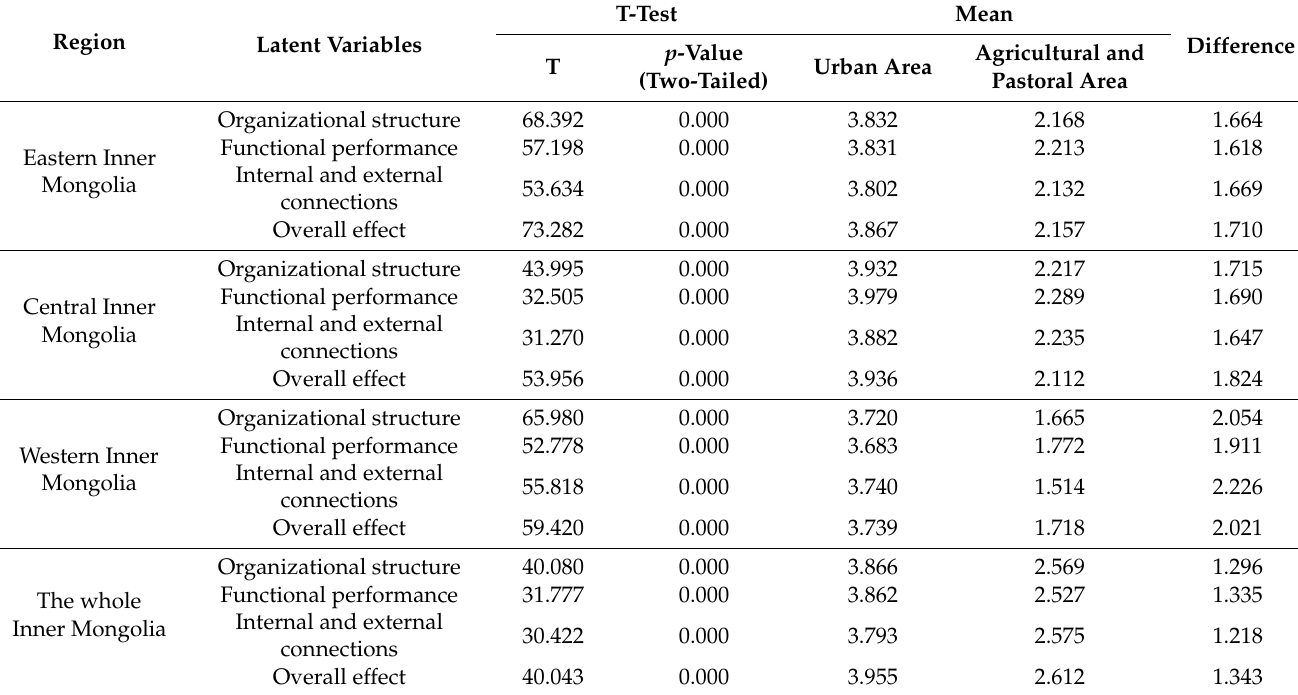
Table 4. Comparison of latent variables and the overall scores of community intervention among the regions.